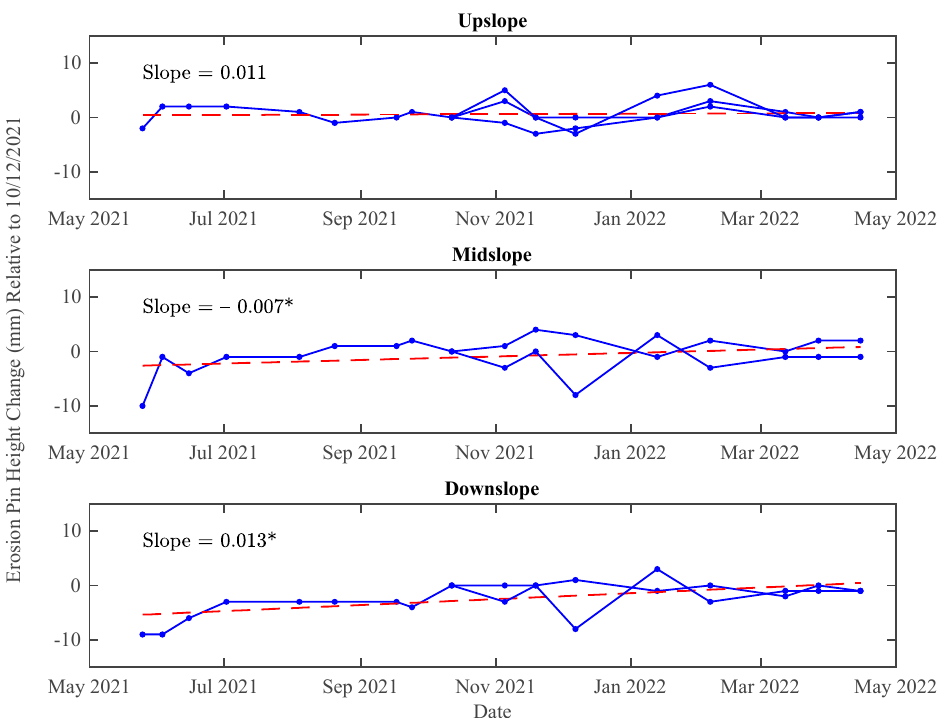
Figure 8. Linear regression for the plot with vetiver between time in days and erosion pin height relative to the measurement on 12 October 2021, when all erosion pins were installed and stabilized. Solid blue lines and markers show the trajectory of measurements for each erosion pin and dashed red lines show the regression line. Regression slope is given in each plot with * indicating a regression p -value less than 0.1. Regression lines are calculated separately for upslope ( top ), midslope ( middle ), and downslope ( bottom